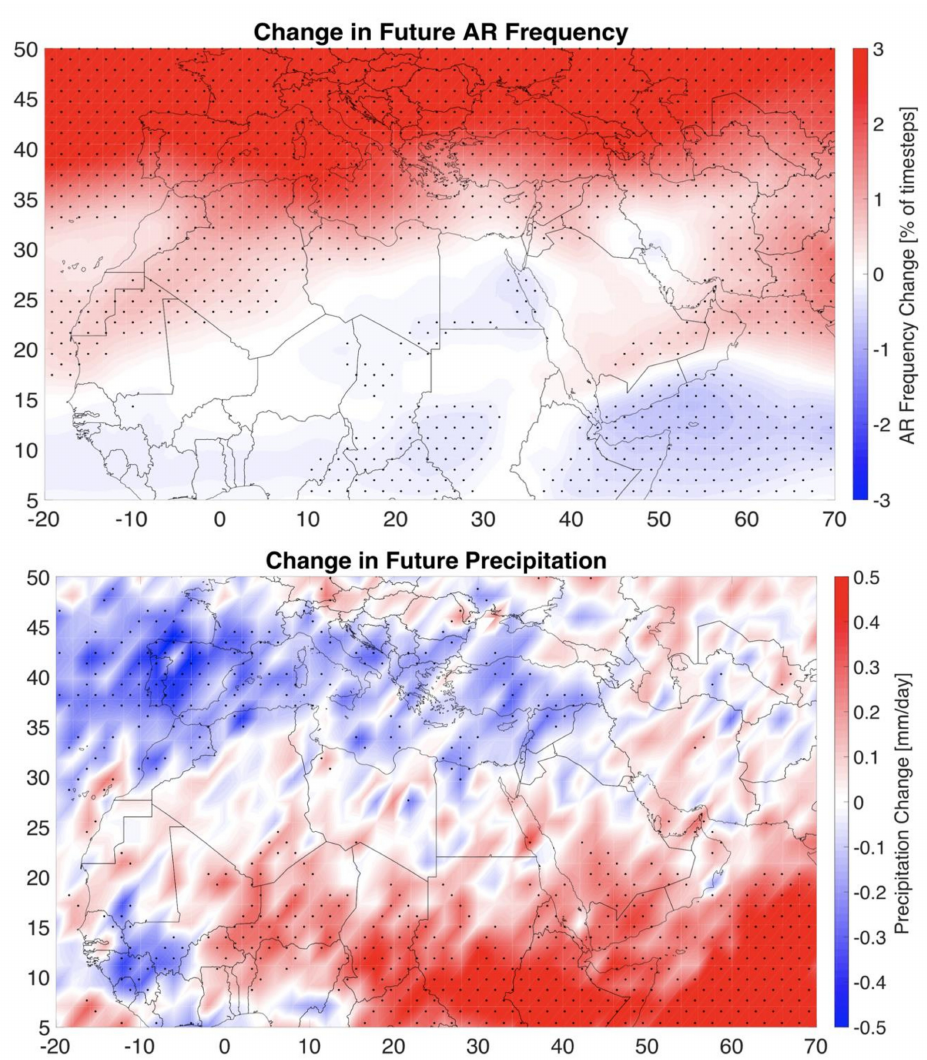
Figure 8. ( Top ) Raw values for the projected change in future AR frequency [% of timesteps], calculated as the di ff erence between projected future values and historic climatology for the MENA region. ( Bottom ) Raw values for the projected change in future mean daily precipitation [mm / day] for the MENA region. The CMIP5 historical simulations range from 1979–2002 and the future (RCP8.5) scenario simulations range from 2073–2096. Grids with a black dot indicate where the projected change in AR frequency or precipitation is statistically significant, based on a paired-sample t -test with p =